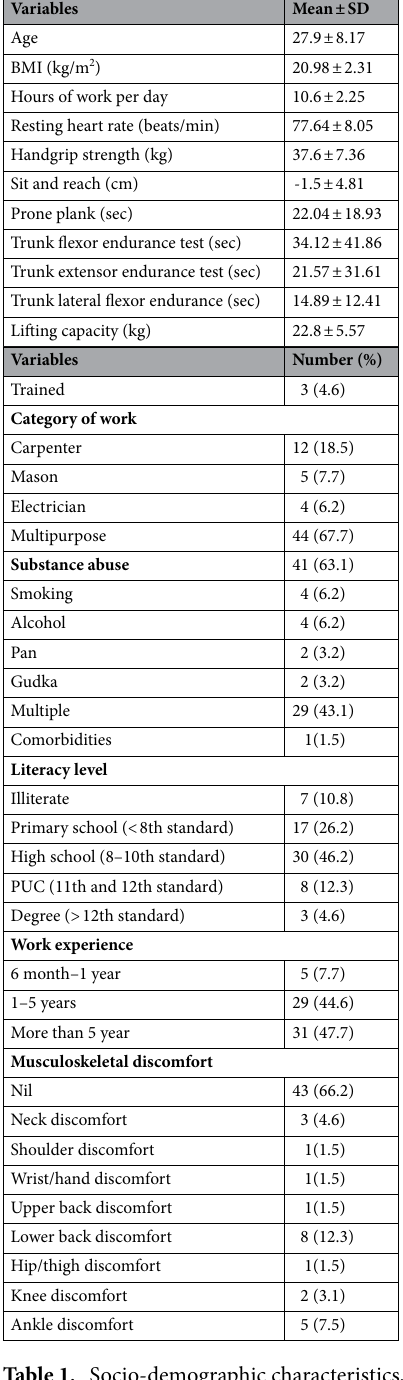
Table 1. Socio-demographic characteristics, lifting capacity, and physical performance measures (n =